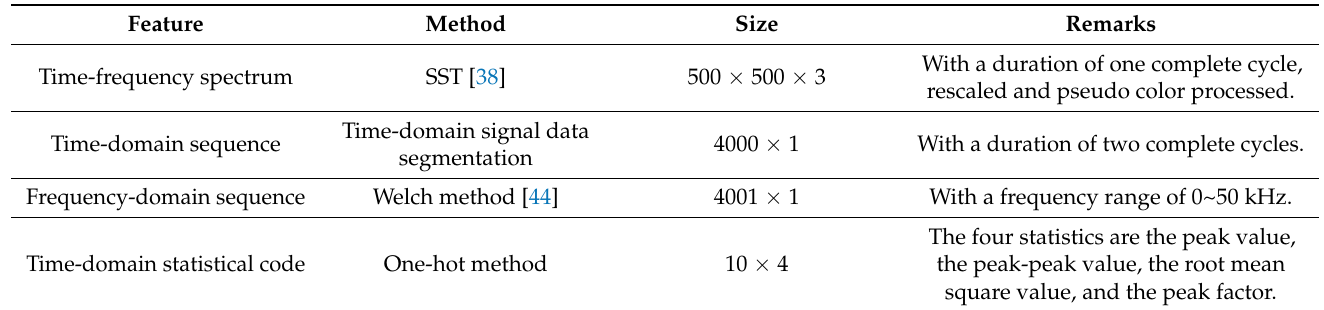
Table 2. Features used in the proposed